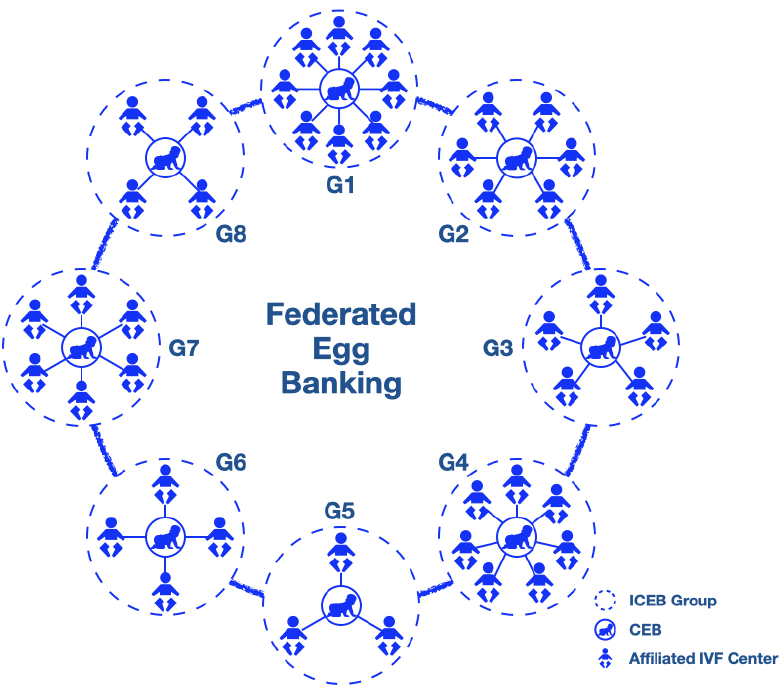
Figure 3. The federated egg banking business